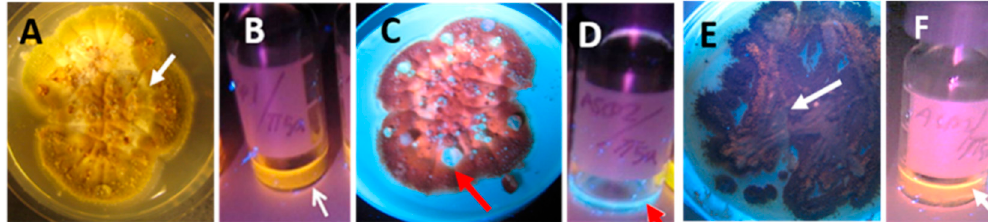
Figure 5. Plate-grown biomass, biomass dispersals and exudates from Trichoderma trixiae strain LB1 grown on malt extract agar. The panels were pictured in visible ( A , D ) and UV ( B , C , E , F ) light. ( A , B ) biomass of a culture in the late stationary phase (>4 weeks); ( C ) biomass lysate of a culture in the late stationary phase (>4 weeks); ( D , E ) biomass in the early stationary phase (1 week); ( F ) guttation droplets collected in an ampule from the plate-grown biomass in Panel B. The biomass consisted of hyphae, green conidia and blue-fluorescing guttation droplets containing liquid exudates. The bars are 10 mm.